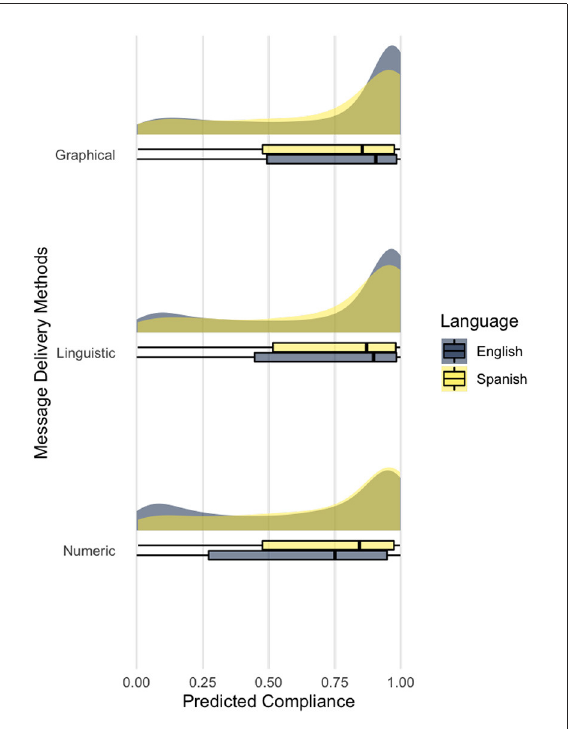
FIGURE7 Predicted compliance rate by messaging type and language.